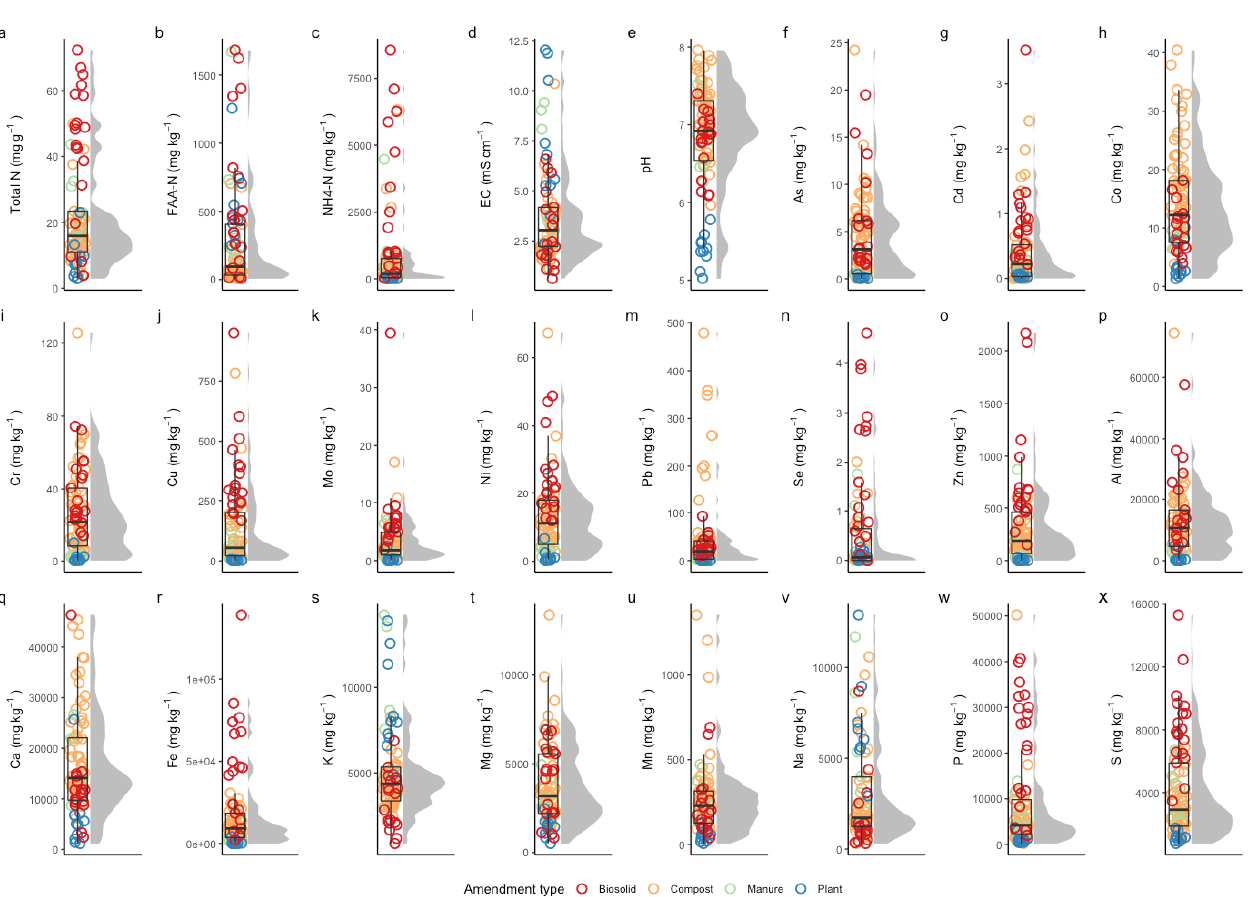
Figure 1. Chemical distribution of plants’ essential nutrients (N, P, K and plant-available form of nitrogen), and total elements derived through chemical analysis from bio-solid (red-color circles), composts (orange-color circles), manure (green-color circles) and plants residues (blue-color circles). y-axis shows the concentration of each element with all units in mg kg − 1 except N which is in mg g − 1 and the number of each element is shown on the x-axis. ( a – x ) Different properties of the 85 bio-based fertilizer